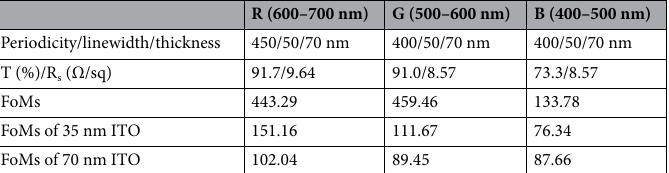
Table 2. Simulated transmittance, sheet resistance, and FoMs of the optimized TCEs within three different wavelength